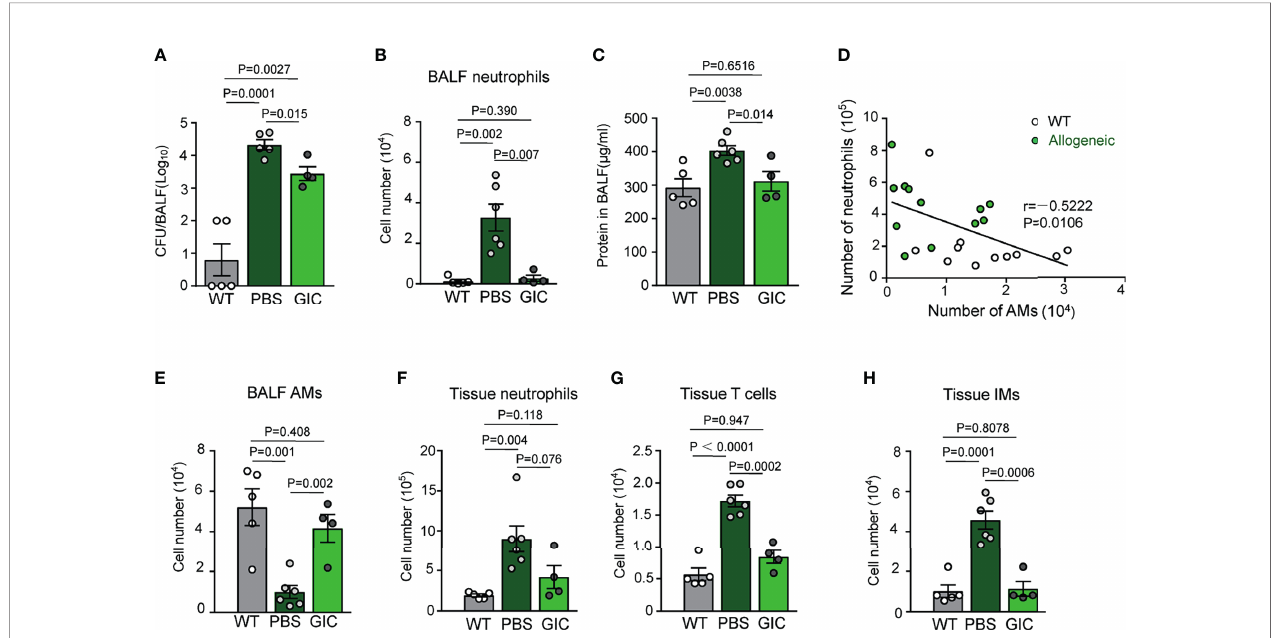
FIGURE 4 | Promoting AM reconstitution increases the resistance of allogeneic recipient mice against respiratory bacterial infection after TCD-BMT. (A) Allogeneic recipient mice of TCD-BM grafts were i.n. treated with PBS or GIC started from day 16 every other day for a total of fi ve times. Two days after the last treatment, these mice were infected with 2 × 10 5 Streptococcus pneumoniae via i.n. 48 h later; bacterial CFUs were analyzed in BAL fl uid. (B) Forty-eight hours after infection, neutrophils in BAL fl uid were analyzed in infected mice by fl ow cytometry. (C) Total protein concentration in BAL fl uid was analyzed in mice 48 h after S. pneumoniae infection. (D) WT mice and 28-day allogeneic recipient mice with TCD-BM grafts were infected with 2 × 10 5 S. pneumoniae via i.n. Forty-eight hours later, the correlation between numbers of AMs and neutrophils in BAL fl uid was analyzed. White circle, WT mice infected with S. pneumoniae ; solid green circle, 28-day allogeneic recipient mice infected with S. pneumoniae . Data shown are the pooled results of three independent experiments with three to four mice per group in each experiment. (E – H) Forty-eight hours after infection, AMs in BAL fl uid, neutrophils, T cells, and IMs in lung tissues were analyzed by fl ow cytometry. Data are represented as mean ± SEM with four to six mice in each group. AM, alveolar macrophage; TCD, T cell-depleted; BMT, bone marrow transplantation; PBS, phosphate-buffered saline; BAL, bronchoalveolar lavage; WT, wild